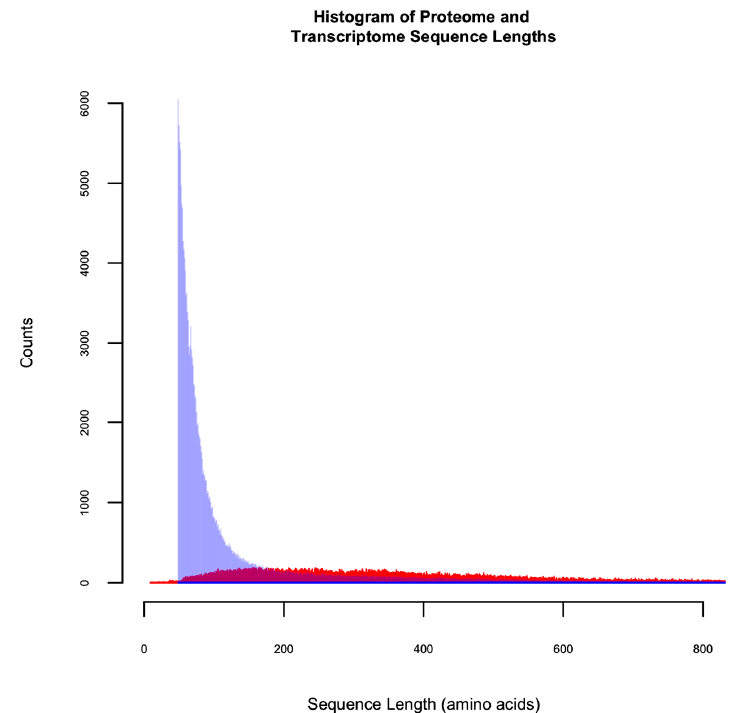
Figure 1. Histogram of the sequence lengths of the NCBI proteome and the transcriptome. The transcriptome is represented in blue, the proteome in